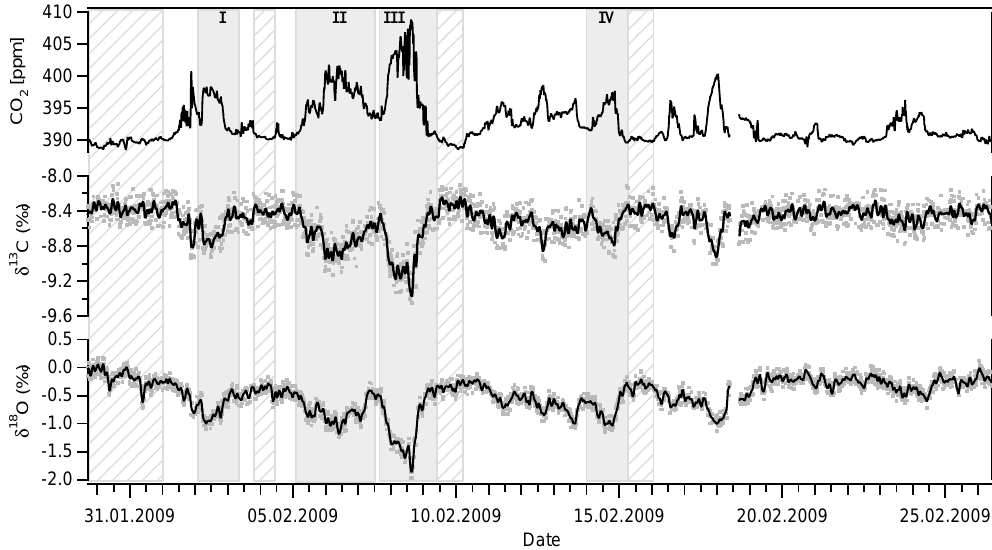
Fig. 3. Time series of tropospheric CO 2 mixing ratio and its isotopic composition. For the delta values, the gray dots represent 10min averages, while the solid line is an interpolation through the data using a smooth spline. The shaded areas indicate distinct pollution events, while periods with the free tropospheric background conditions are highlighted by hatched